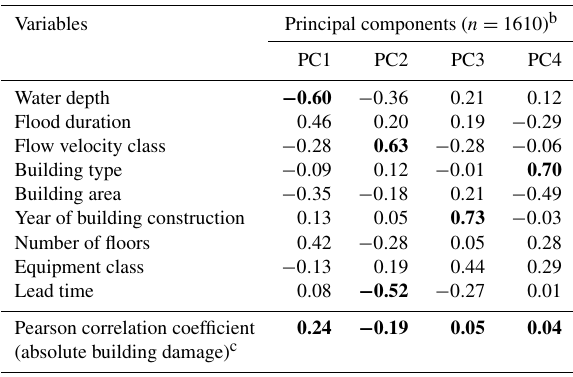
Table 3. Loadings of variables potentially influencing flood damage to buildings in the private household sector a